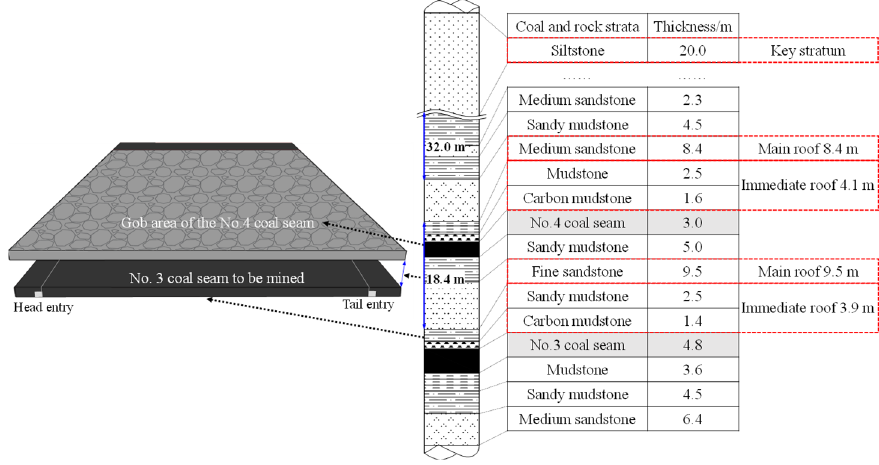
Figure 14. Generalized stratigraphic column of coal seam and strata.